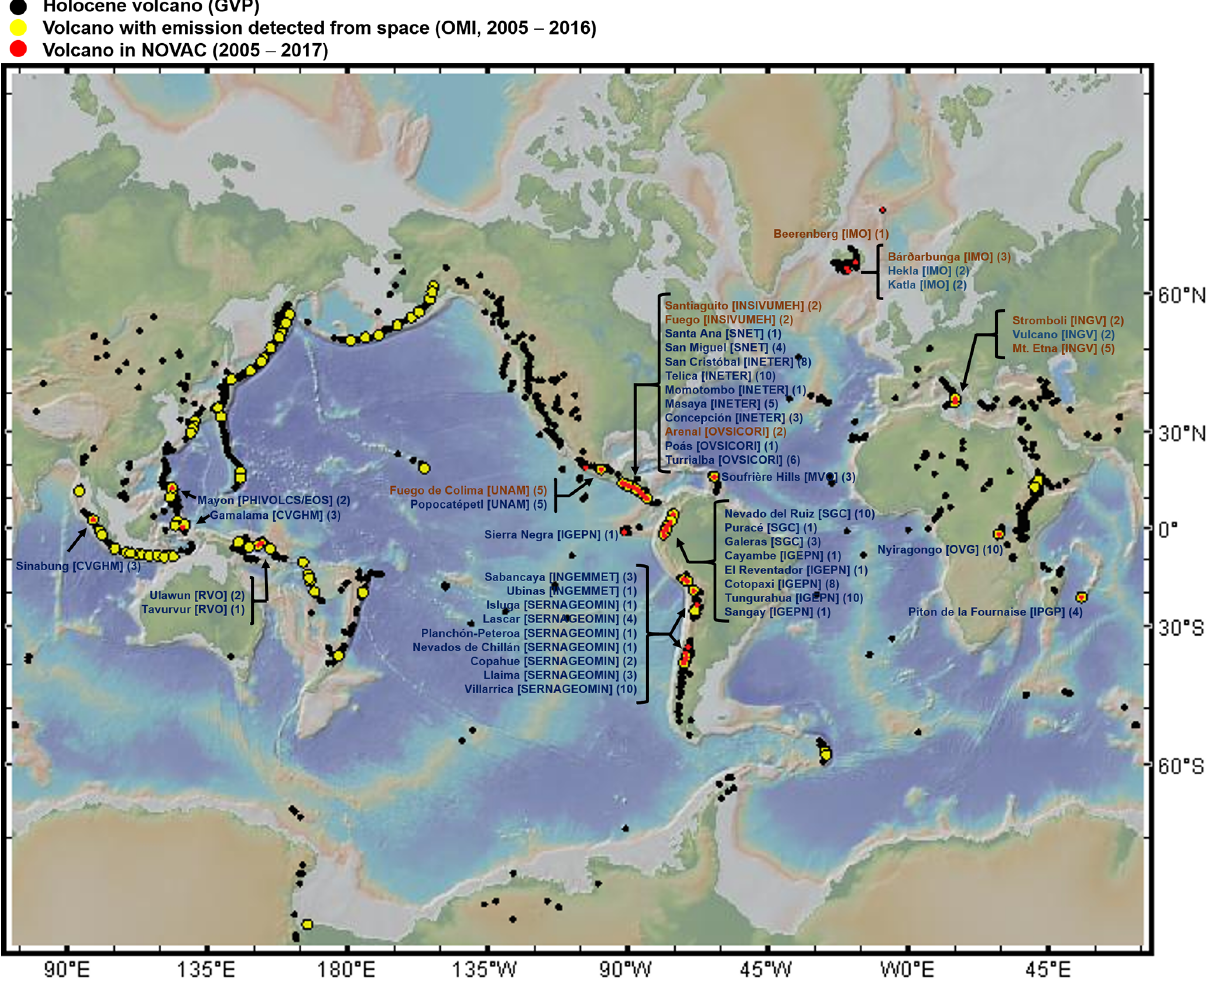
Figure 1. Topographic map showing the locations of volcanoes in NOVAC (red circles). The locations of Holocene volcanoes from the Global Volcanism Program (GVP) of the Smithsonian Institution (2013) are shown with black circles. The locations of volcanoes detected by OMI during 2005–2015 (from Carn et al., 2017) are shown with yellow circles. Beside the names of the volcanoes are the acronyms of the volcanological observatories and the number of stations and configurations installed on each volcano over the years. Blue fonts are used to represent volcanoes observed by NOVAC by the time of writing, and orange fonts are for volcanoes observed in the past or where ready-to- deploy infrastructure is in place. For a list of volcanoes, institutions, contact details and links to the database, see Supplement S1 (base map in Mercator projection, from http://www.geomapapp.org, last access: 1 October 2020, Ryan et al., 2009). CVGHM: Center for Volcanology and Geological Hazard Mitigation; IGEPN: Instituto Geofísico; IMO: Icelandic Meteorological Office; INETER: Instituto Nicaragüense de Estudios Territoriales; INGEMMET: Instituto Geológico, Minero y Metalúrgico; INGV: Istituto Nazionale di Geofisica e Vulcanolo- gia; INSIVUMEH: Instituto Nacional de Sismología, Vulcanología, Meteorología e Hidrología; IPGP: Institut de Physique du Globe de Paris; MVO: Montserrat Volcano Observatory; OVG: Observatoire Volcanologique de Goma; OVSICORI: Observatorio Vulcanológico